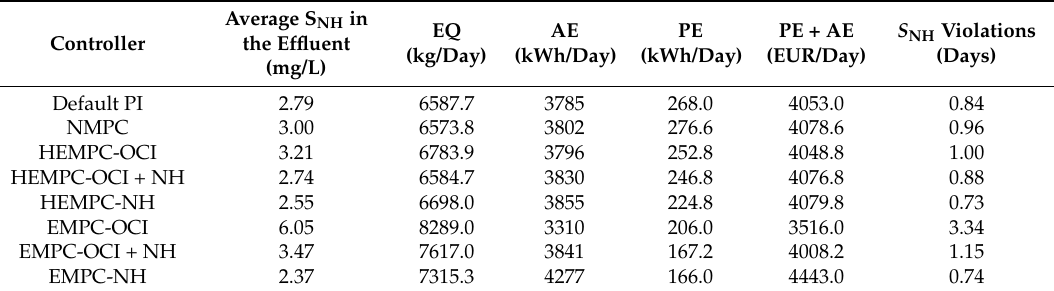
Table 2. Performance indices associated with variables of the plant optimized in the economic oriented model predictive controllers cost function (computed for a four-day operation period under dry weather disturbances). NMPC: non-linear model predictive controller; HEMPC: economic-oriented tracking controller; OCI: overall cost index penalization; NH: off-specification ammonium load in the effluent penalization; EMPC: economic-oriented model predictive controller.